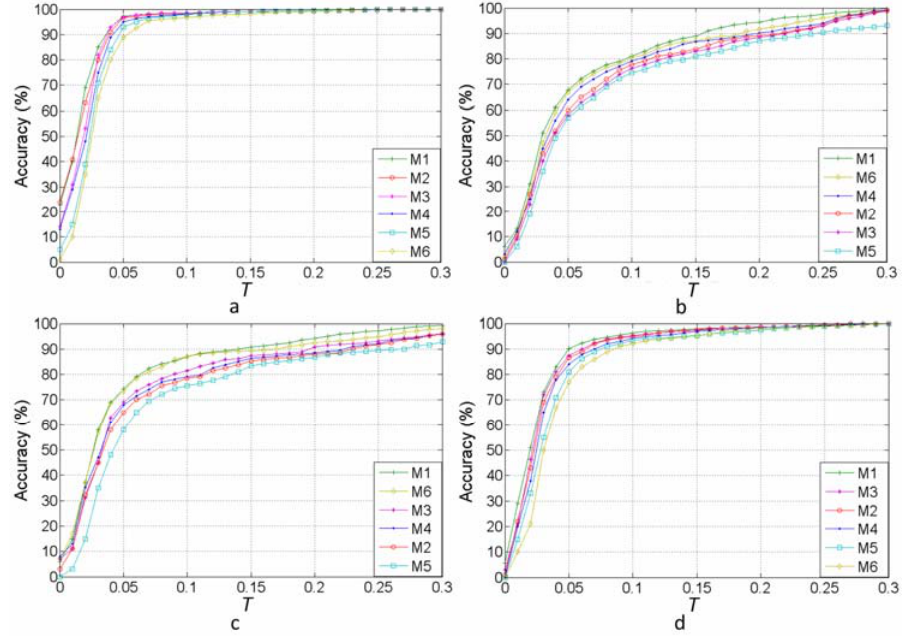
Figure 18: The distribution functions of relative error against accuracy of six methods (M1, M2, M3, M4, M5, and M6) with respect to true iris center. (a) Center, (b) Left, (c) Right, (d) Upper.